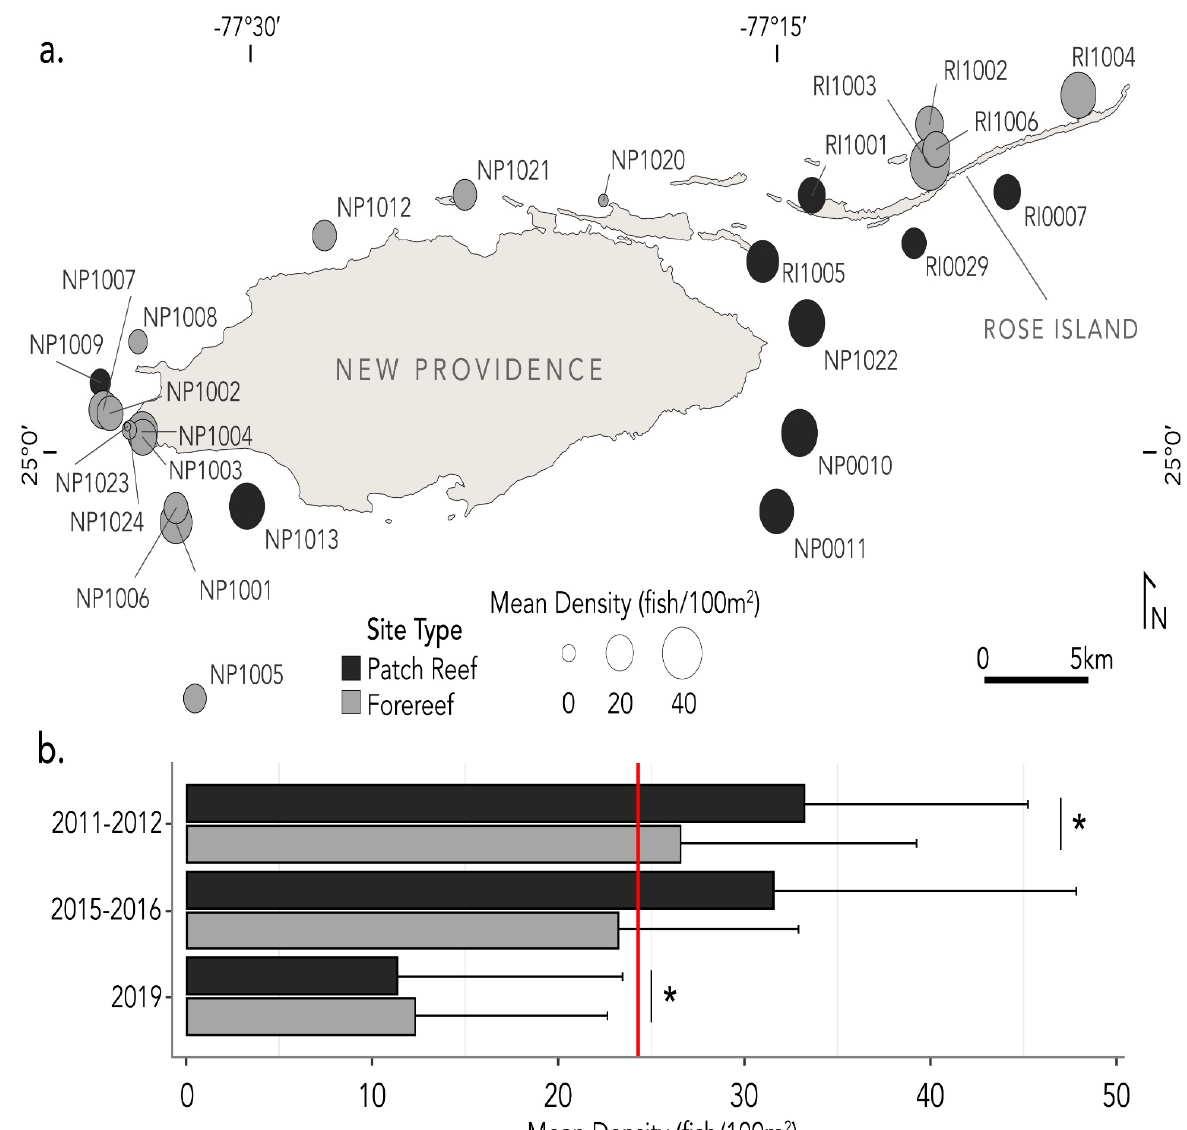
Figure 2. ( a ) Mean densities (number of individuals per 100 m 2 ) by site and reef zone averaged across all survey periods. Patch reef are in black and forereef sites are in grey. ( b ) The mean densities (number of individuals per 100 m 2 ) of all parrotfish (Scarini) on coral reefs around New Providence for each survey period, with error bars showing the standard deviation (±SD) of the data. The red line denotes the regional mean value (24.3/100 m 2 ) of parrotfish densities (AGRRA 2018). Significant differences across survey periods are denoted with an asterisk.